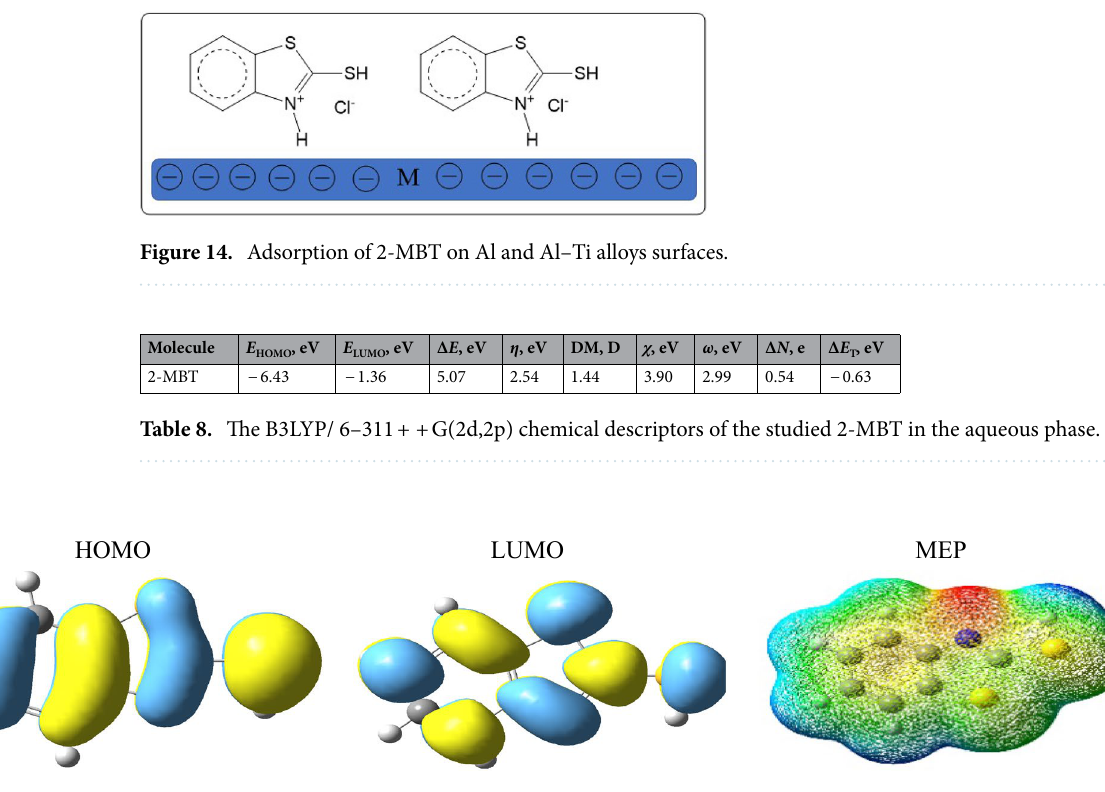
Figure 15. The estimated FMOs and MEP of the investigated inhibitor using B3LYP/6-311++ G(2d,2p) in the aqueous